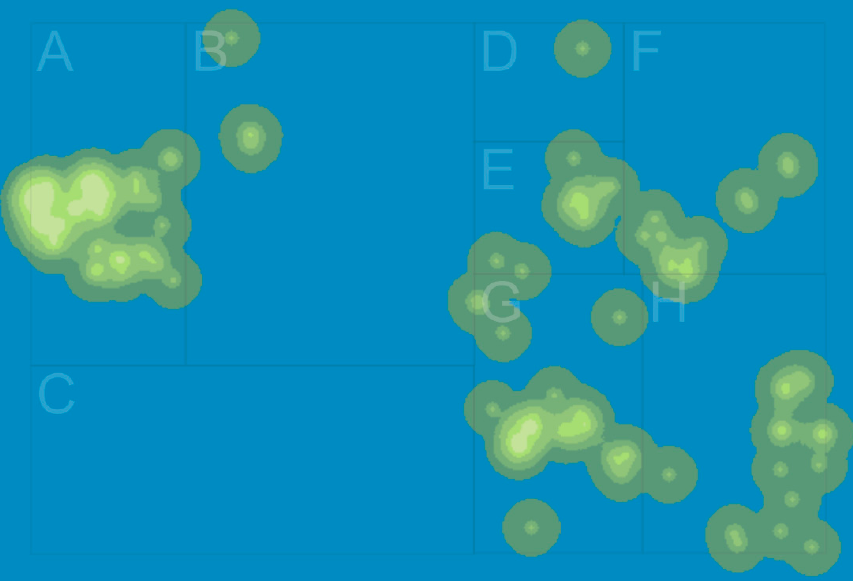
Figure 4. IPC Code Map for our patent pool based on selected patents from the search of the “Smart Furniture” phrase in Title, Abstract, Claims and Description.